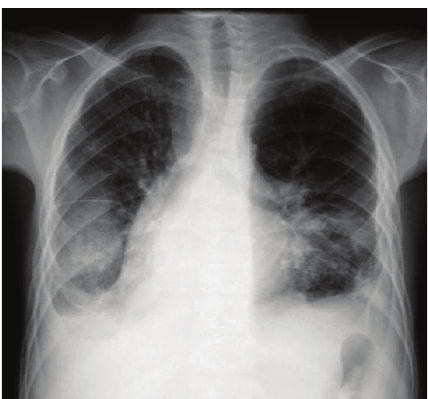
Figure 1: Posteroanterior chest radiography: mild cardiac dila- tion and bilateral pulmonary effusion, predominantly in the right hemithorax.